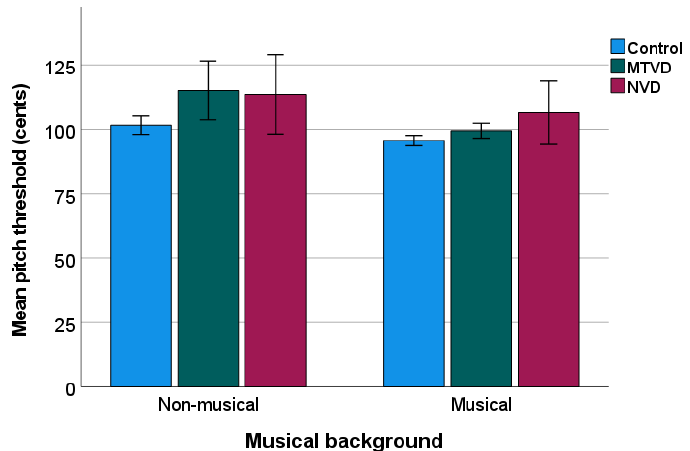
Figure 4. Mean pitch discrimination threshold of sub-groups. The lower pitch threshold, the better discrimination ability. Error bars indicate standard errors. MTVD: muscle tension voice disorder; NVD: neurological voice disorder.